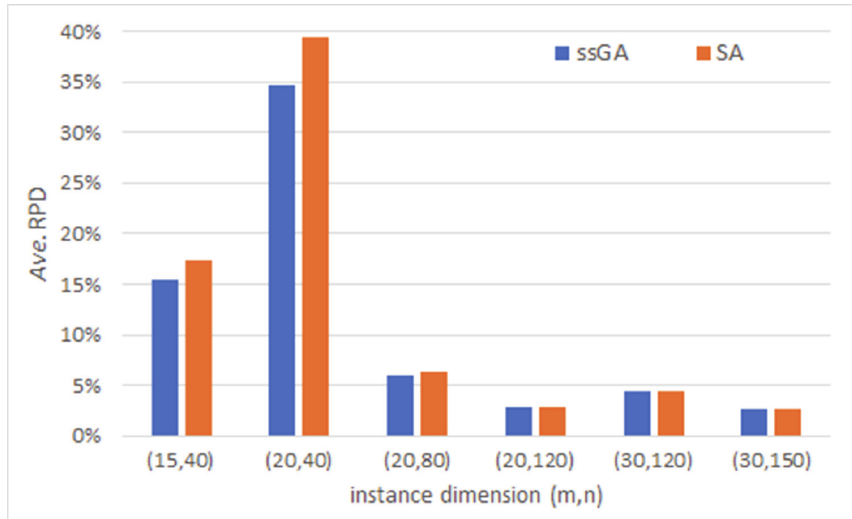
Fig. 2. Ave. RPD PFS results for ssGA in PFS problem variant and SA in NPFS problem variant, considering a 10% of zero values in the processing times